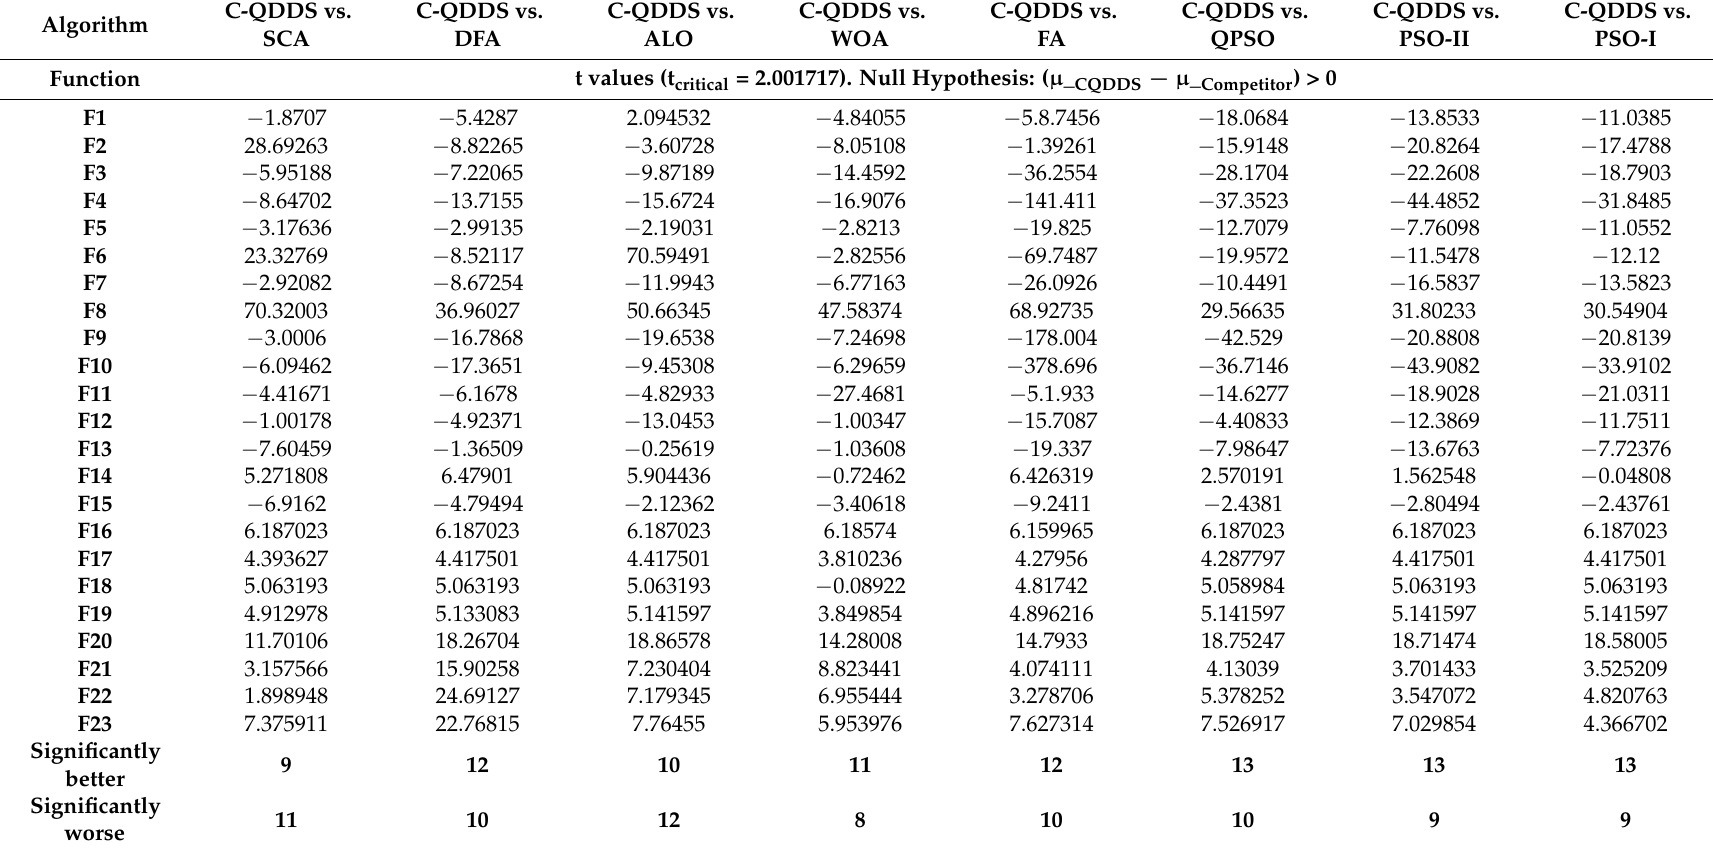
Table 15. Results of two-tailed t -test for C-QDDS vs.